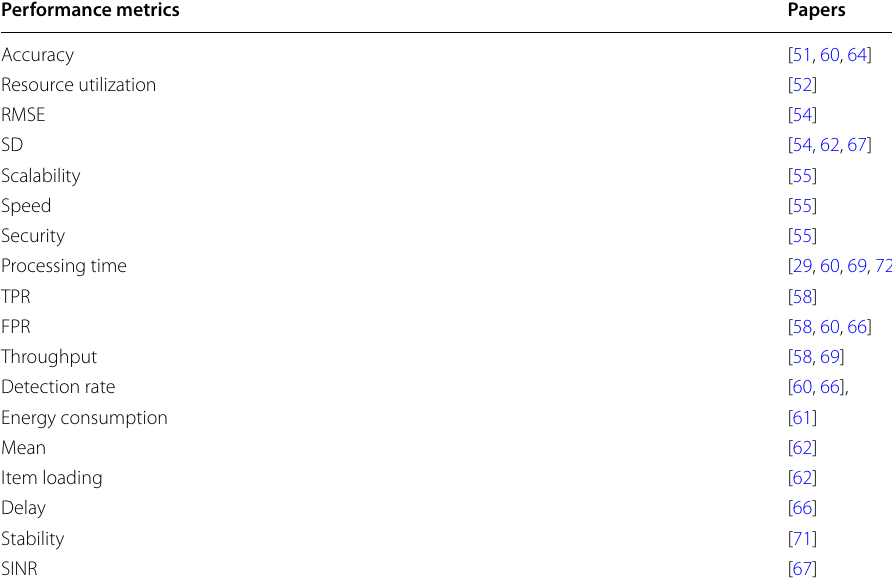
Table 2 Analysis based on the performance metrics Performance